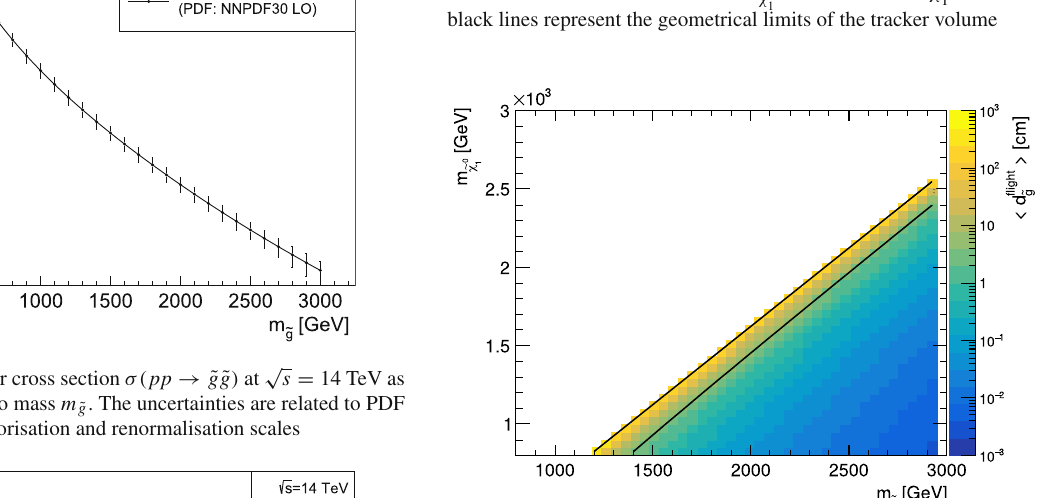
Fig. 63 Leading order cross section σ( pp → ˜ g ˜ g ) at a function of the gluino mass m ˜ g . The uncertainties are related to PDF variations and the factorisation and renormalisation scales